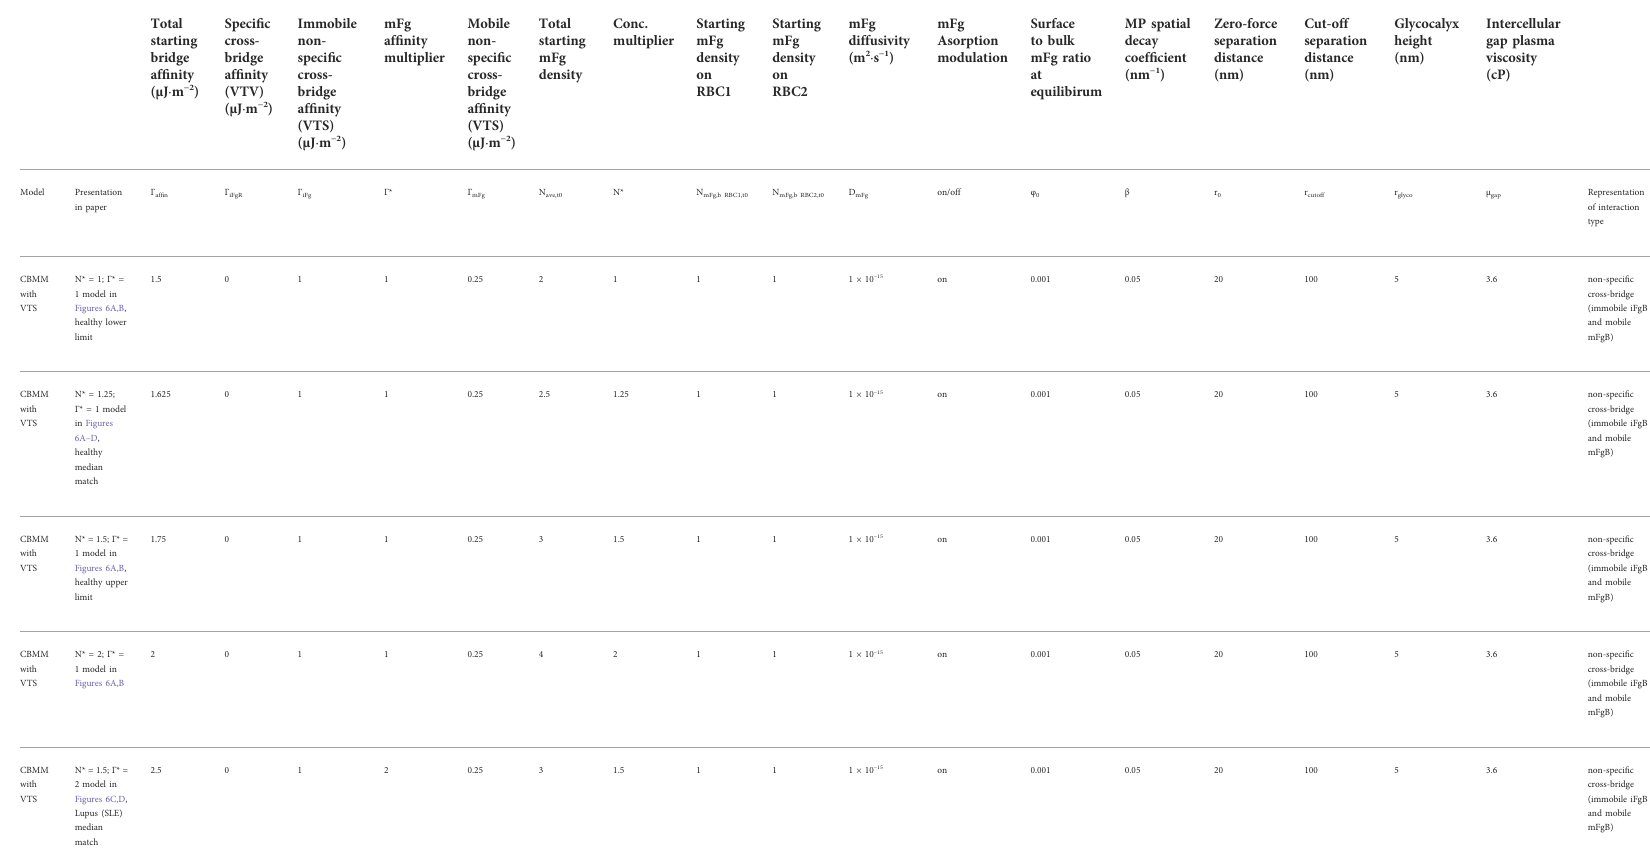
TABLE 4 Simulation parameters for CBMM investigation of pathophysiological